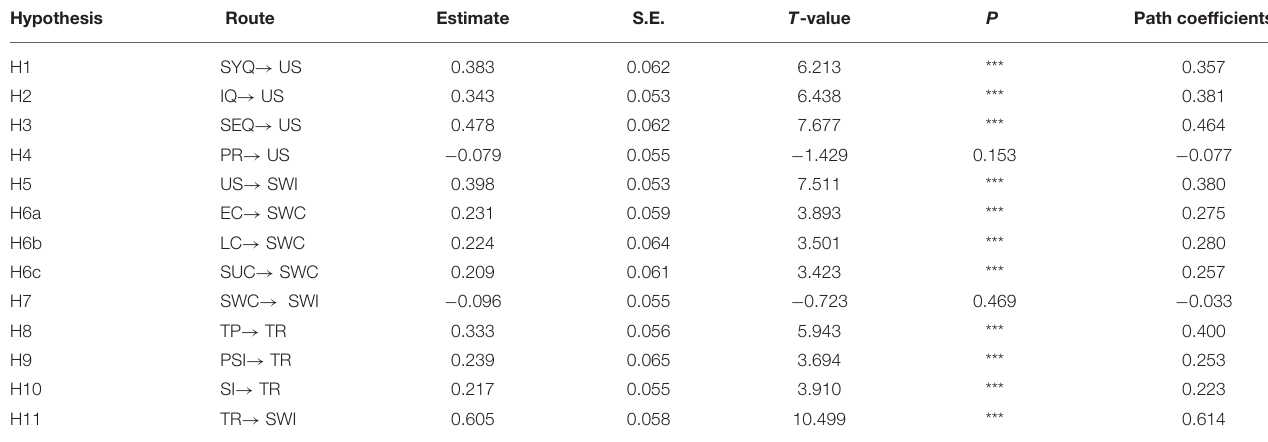
TABLE 5 | Results of hypotheses tests. Hypothesis